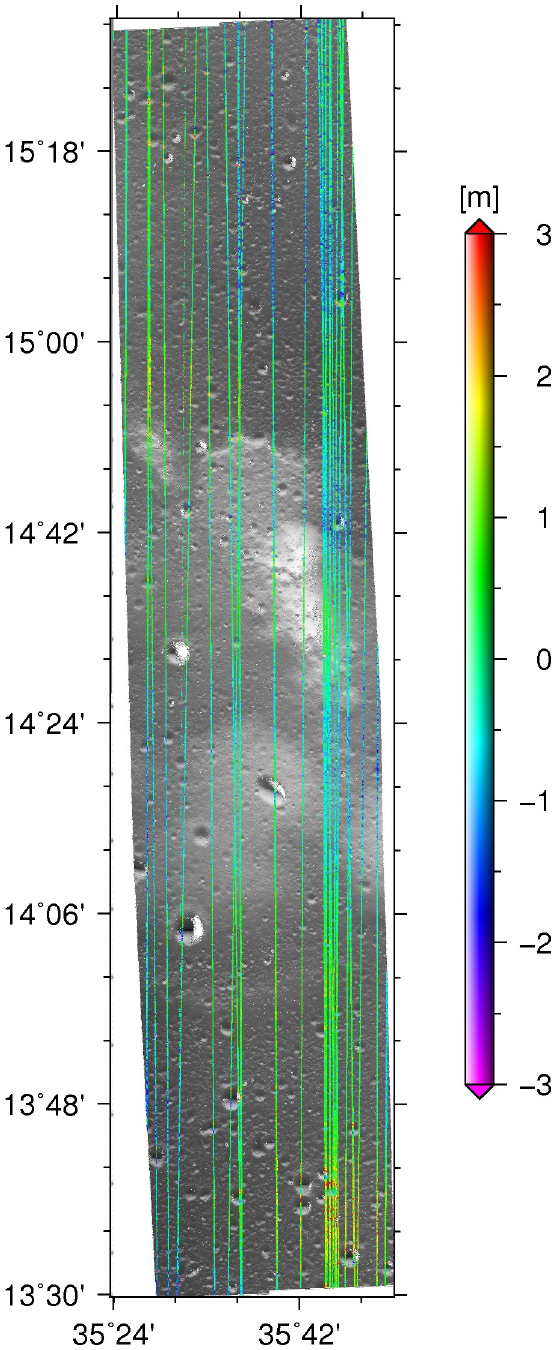
Figure 7: LOLA tracks are color-coded by the height differences of the LOLA shots with the underlying, adjusted LROC NAC DTM. The DTM agrees very well with the registered LOLA tracks, and the majority of the points agree within ±1 m.